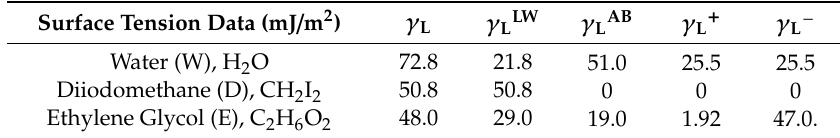
Table 2. Test liquids and their surface tension components